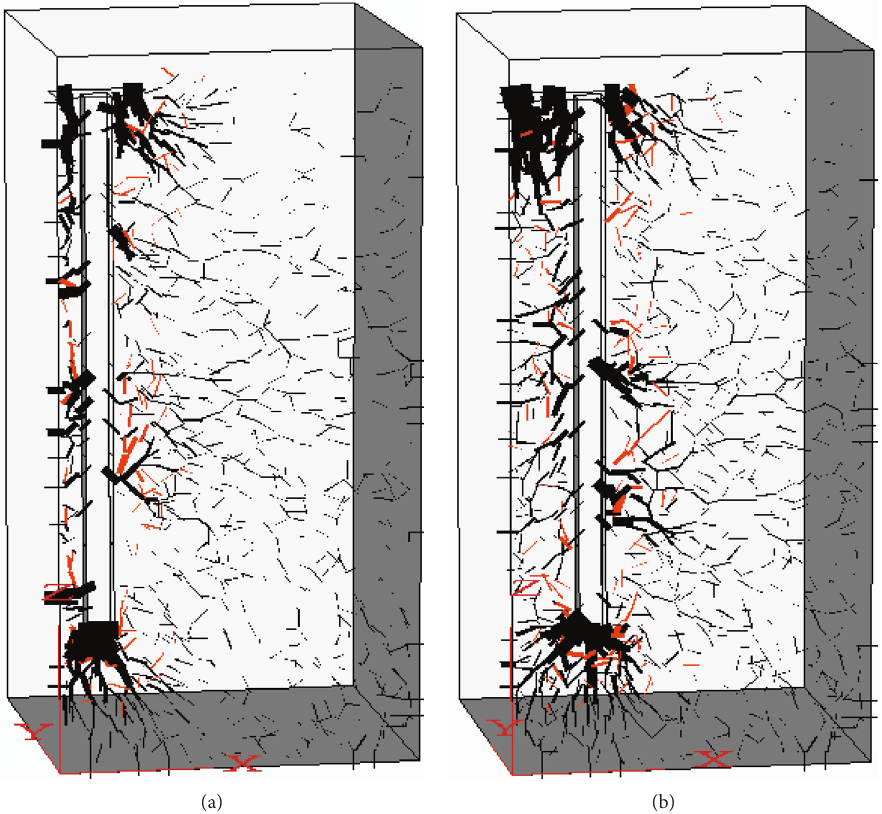
Figure 17: Force chains between the pile and sand. (a) 3 b pile spacing. (b) 6 b pile